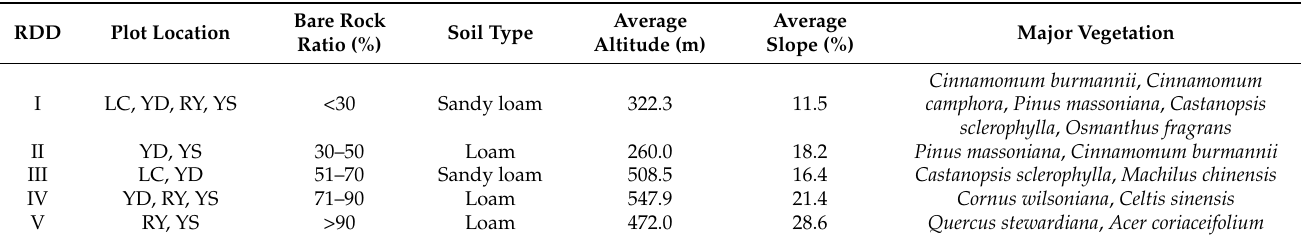
Table 1. The basic information of the sample plots. Note: LC, Lechang; YD, Yingde; RY, Ruyuan; YS,